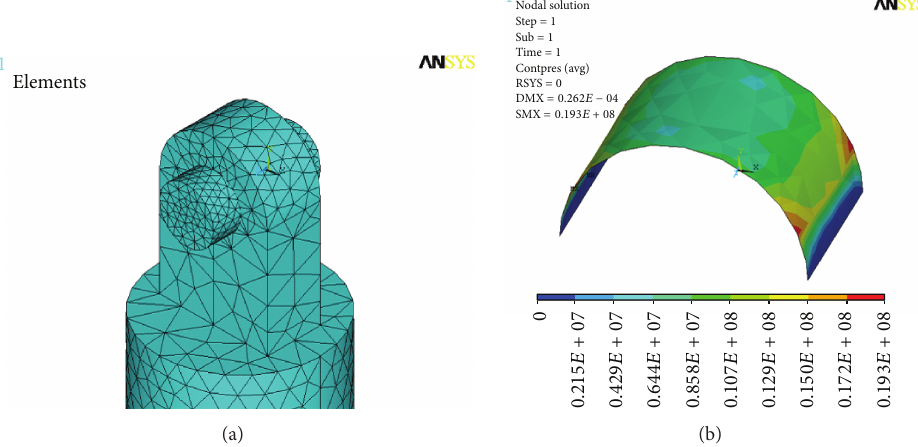
Figure 6: FE model and nonlinear contact analysis results exported by ANSYS. (a) FE model of the top hinge; (b) contour picture of the pressure on the contact surface of